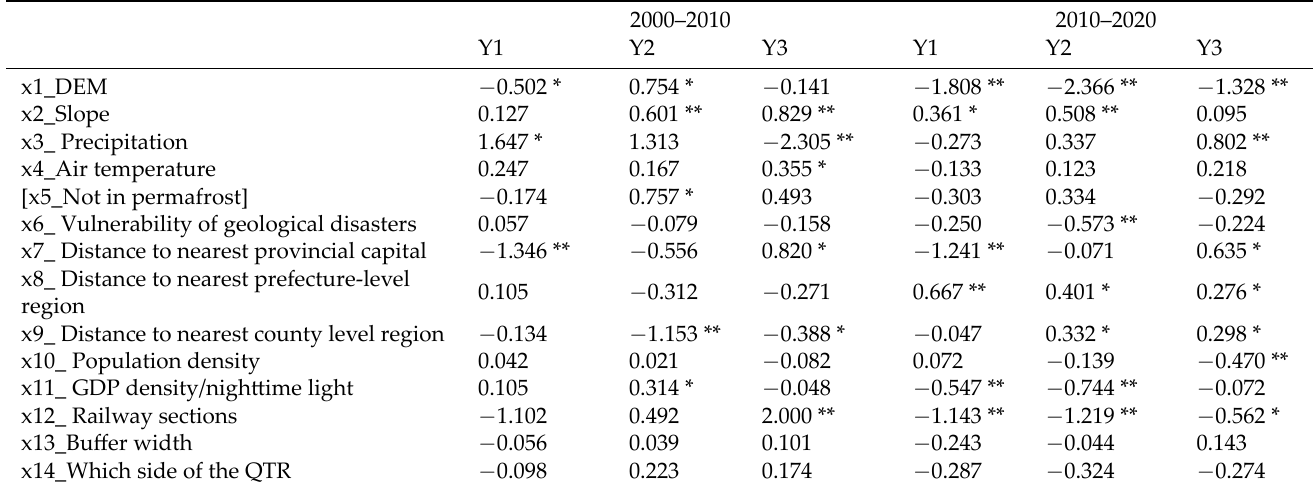
Table 4. Results of multinomial logistic regression